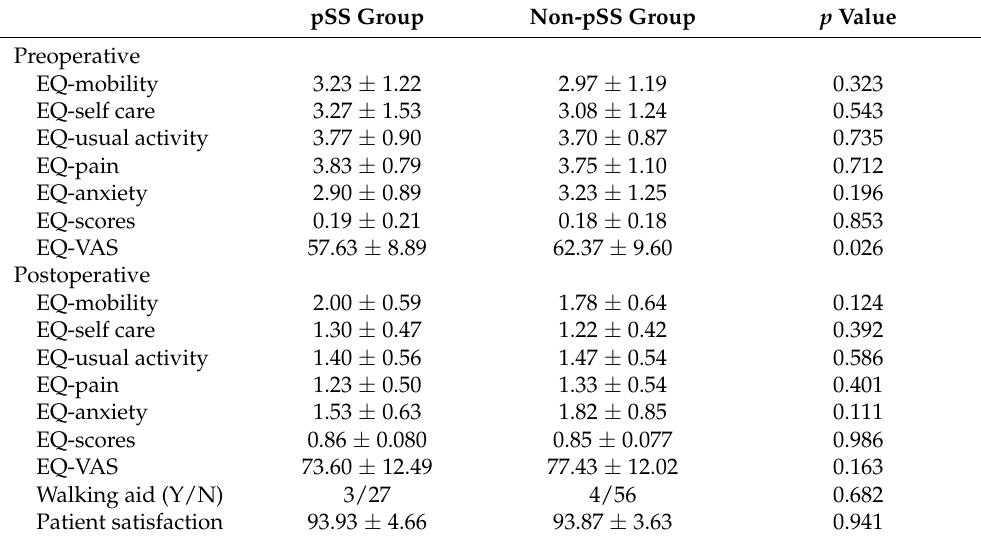
Table 3. Health-related quality of life assessment outcomes.